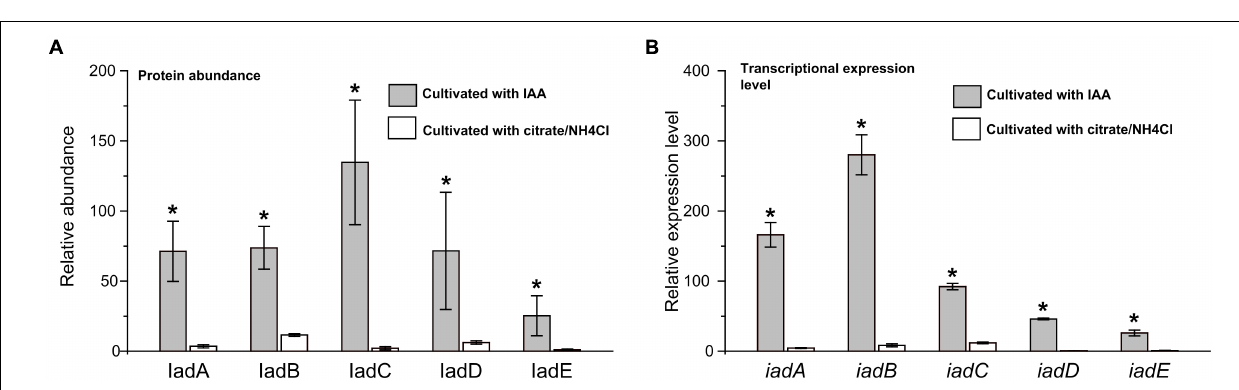
FIGURE 7 | Expression level of IAA degrading relative genes in iad cluster. (A) Protein abundance levels of IAA degrading enzymes in the IAA group (gray bar) and the IAACon group (white bar). (B) qPCR analysis of the IAA degrading genes that were differentially expressed in IAA group (gray bar) and IAACon group (white bar). The least protein abundance and expression level of iadE in the IAACon group were set as 1. t -test was used to calculate statistical significance between IAA and IAACon group. * p <